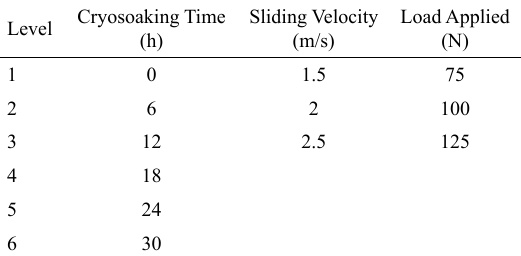
Table 2. Factors and corresponding